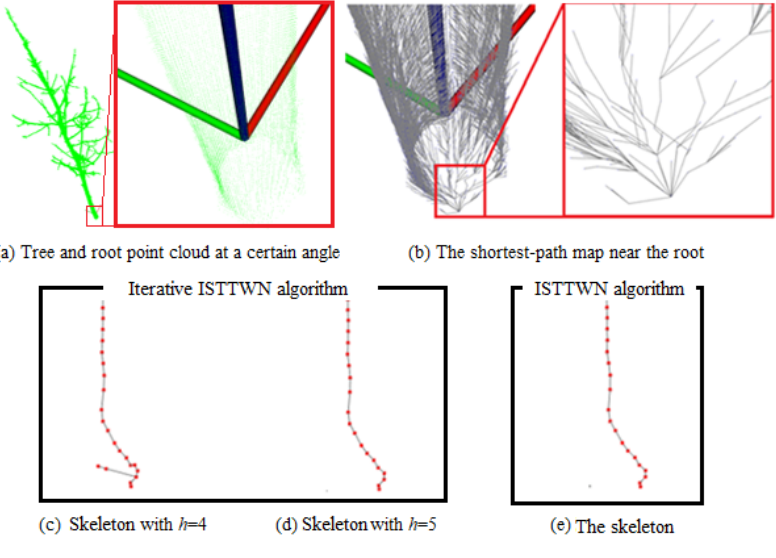
Figure 8. Skeleton near the root.